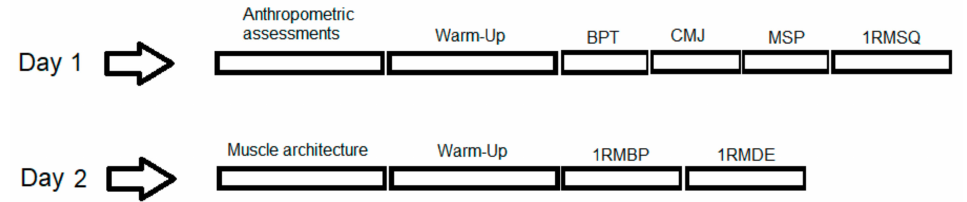
Figure 1. Timeline of the assessments performed in Day 1 and Day 2. MSP = Mid Shin Pull test; BPT = bench press throw; CMJ = countermovement jump; 1 repetition maximum (1RM)SQ = 1RM squat; 1RMBP = 1RM bench press; 1RMDE = 1RM